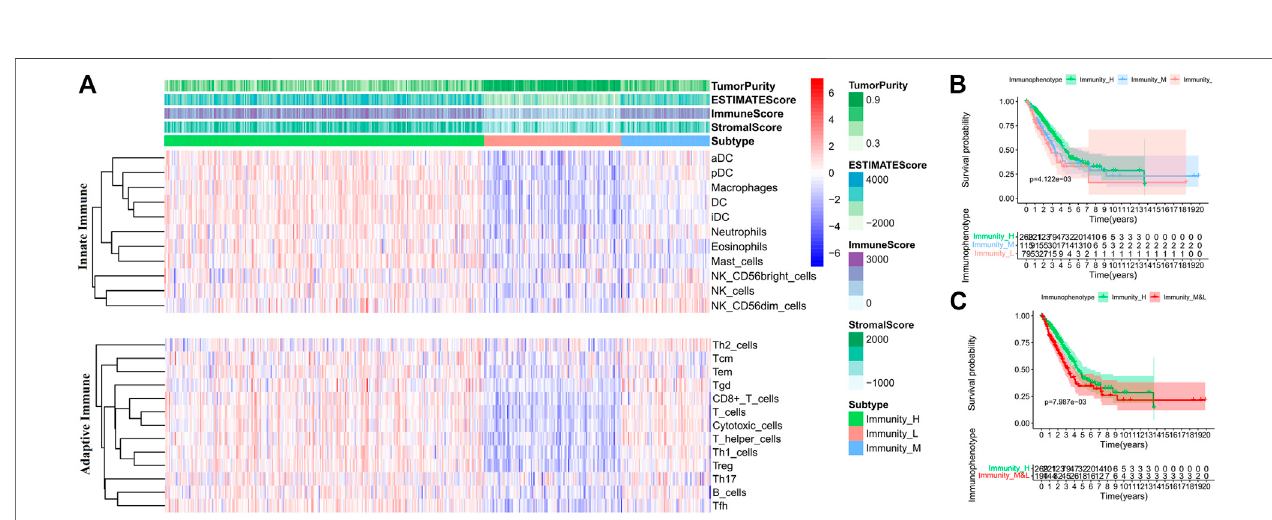
FIGURE 2 | Comparison of TIICs and overall survival (OS) of patients in each immunophenotype in the training set. (A) TIIC contents of patients in each immunophenotype. (B) Comparisons of OS among the three immunophenotypes. (C) Comparisons of OS between Immunity_H and other patients.